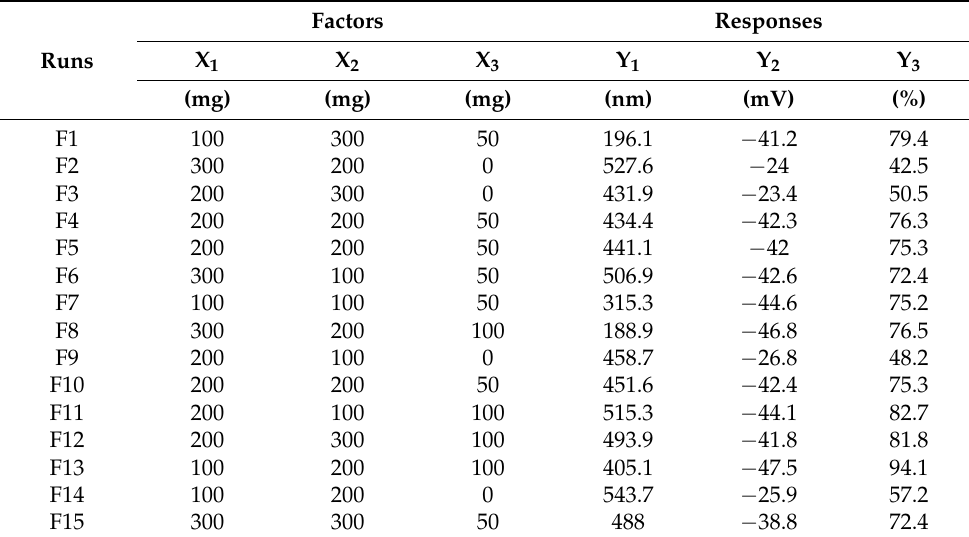
Table 2. Experimental runs and observed values of responses for